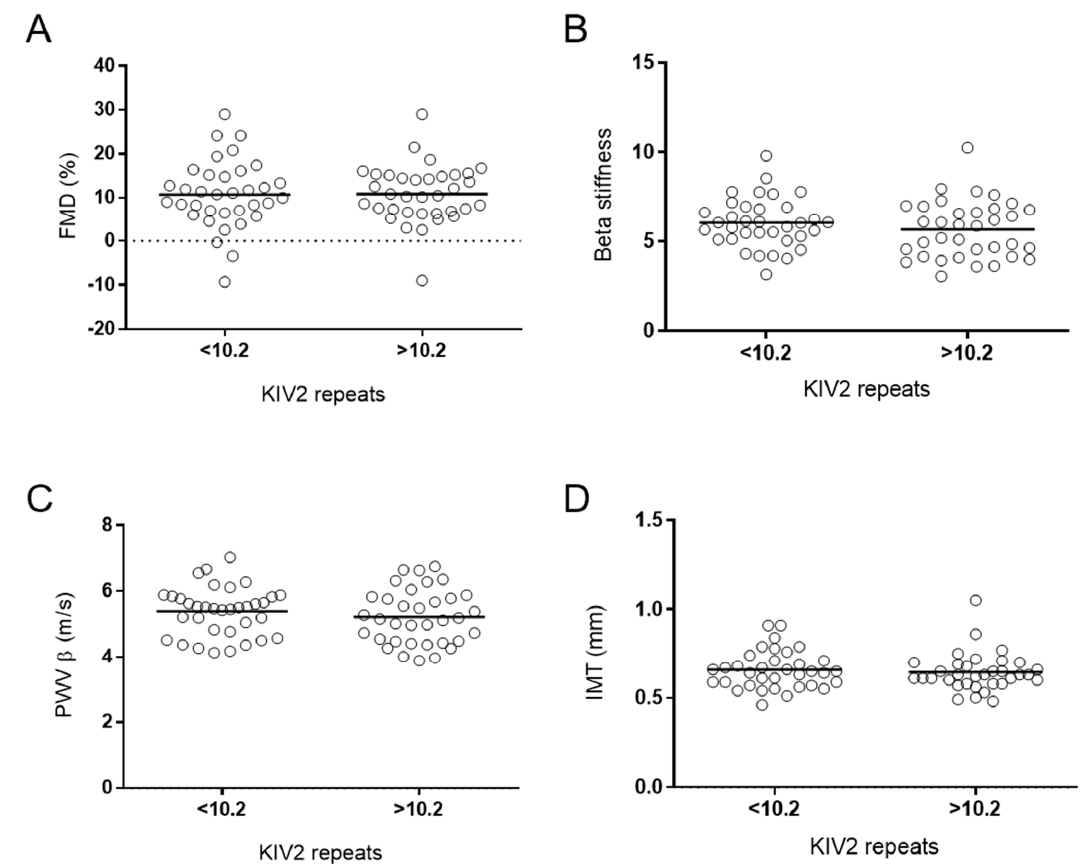
Figure 3. Morphological and functional parameters of arterial wall and KIV2 repeats. Morphological and functional parameters were compared between two groups of KIV2 repeats based on the median of KIV2 repeats, i.e., 10.2, using Student’s t -tests. ( A ) FMD, flow-mediated dilatation; ( B ) beta stiffness; ( D ) IMT, intima–media thickness; ( C ) PWV β , pulse wave velocity β .